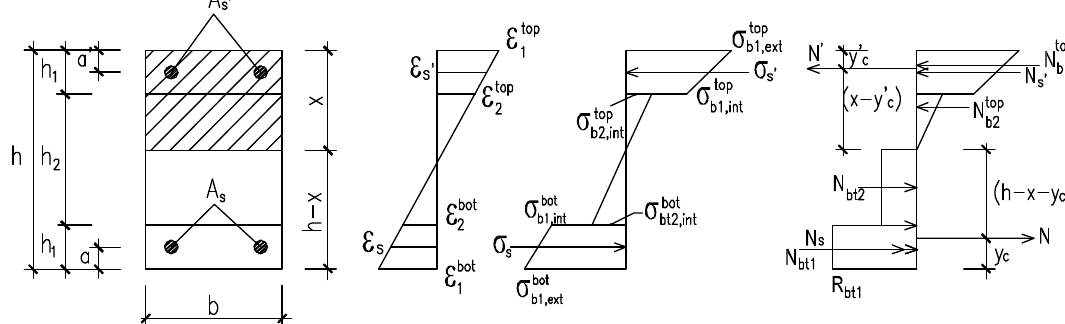
Figure 5. The calculation scheme B for the distribution of deformations, stresses, and forces in the three-layer without considering the contact interlayers [1].